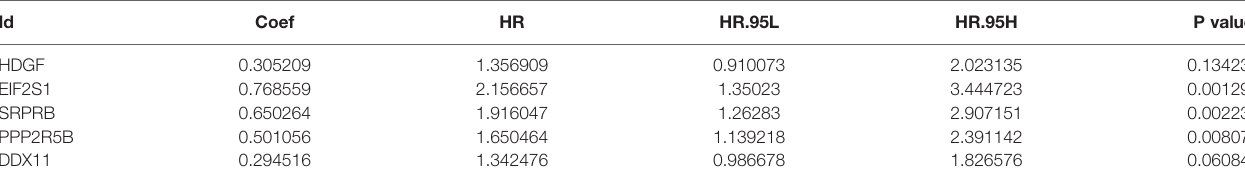
TABLE 2 | Multivariate Cox regression analysis of the 5 genes associated with ERS in the training set of TCGA cohort.